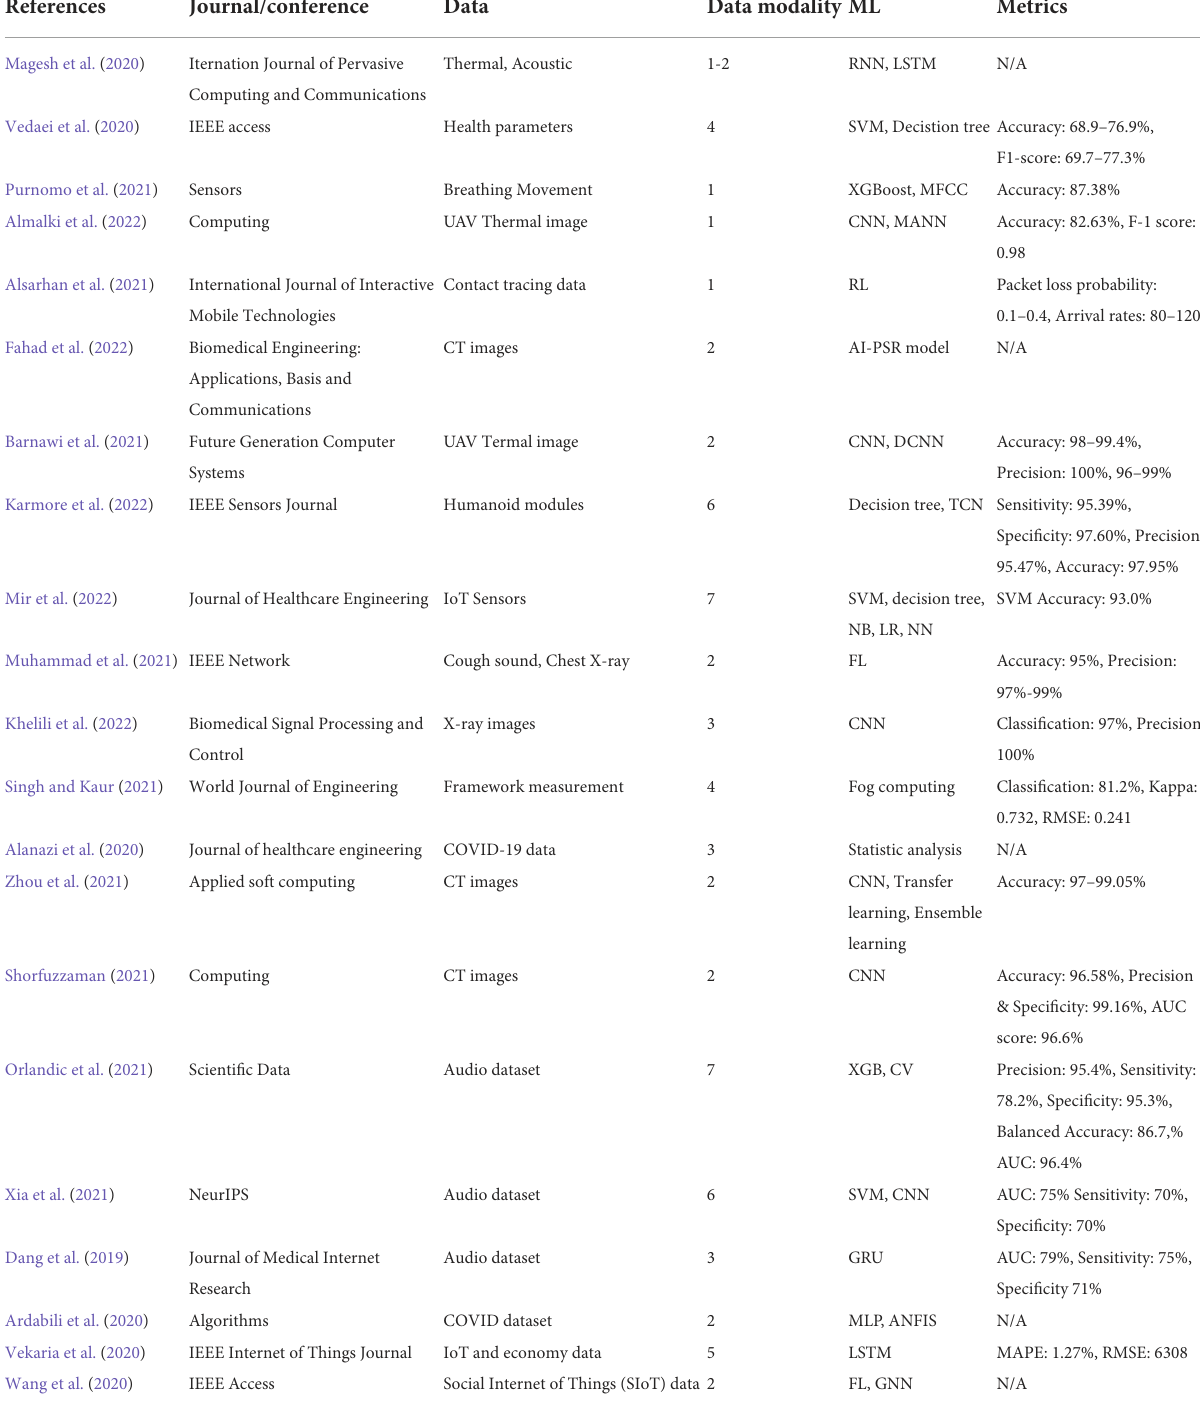
TABLE 5 Summary of ML models, data modalities, and metrics of the papers reviewed in this